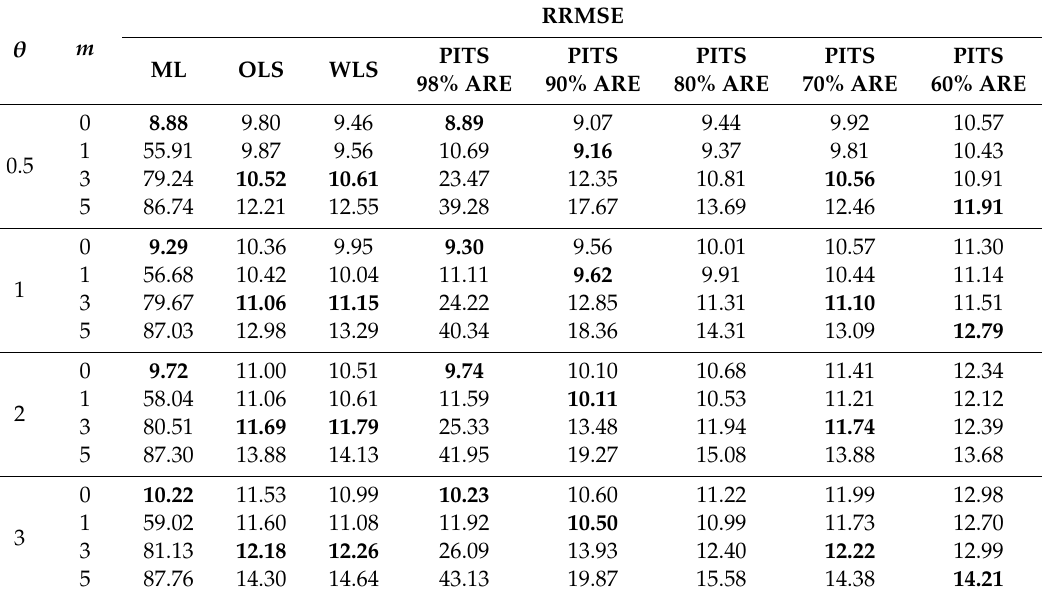
Table 5. RRMSE results for estimations of parameter θ with n = 70 and m = 0, 1, 3,